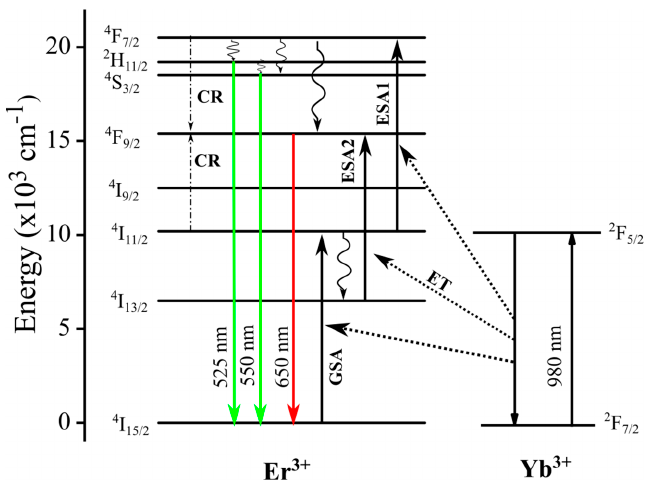
Figure 5. Schematic energy level diagram of co-doped Er 3+ and Yb 3+ ions and possible transition processes.